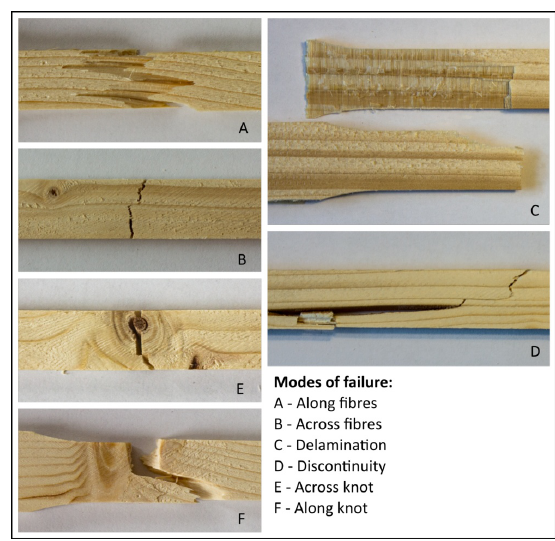
Figure 2. Modes of